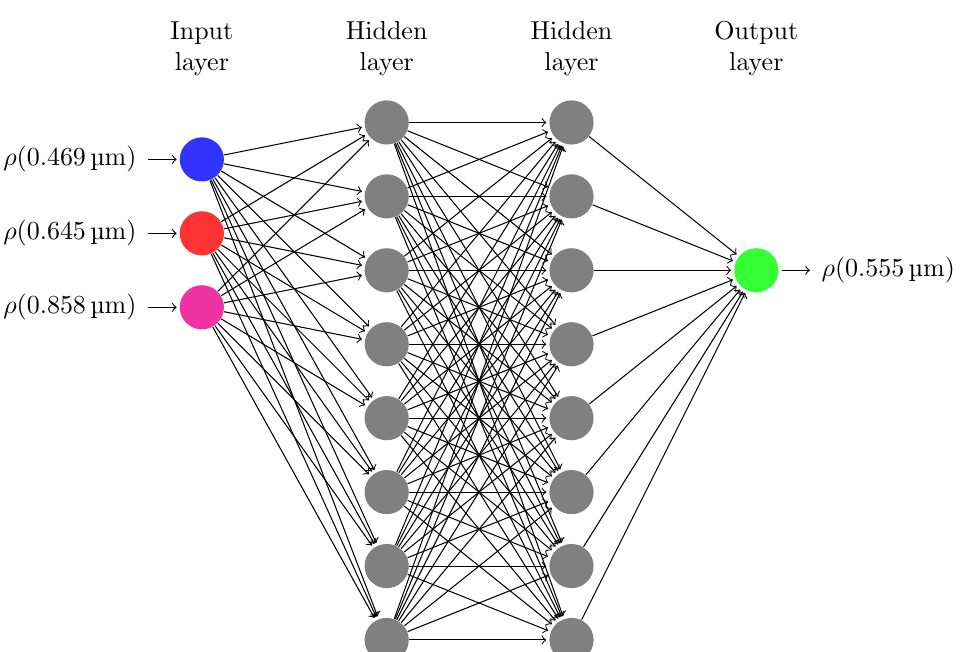
Figure 7. Topology of the artificial neural network (ANN) with one input layer taking 0.469, 0.645 and 0.858µm as the reflectance values and 0.555µm as the target value.